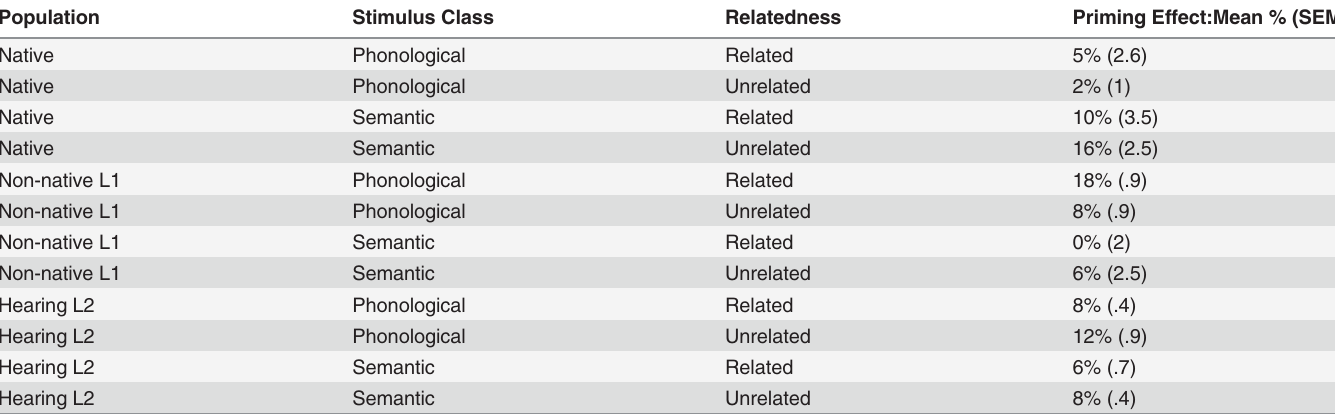
Table 1. Priming effect by population and stimulus